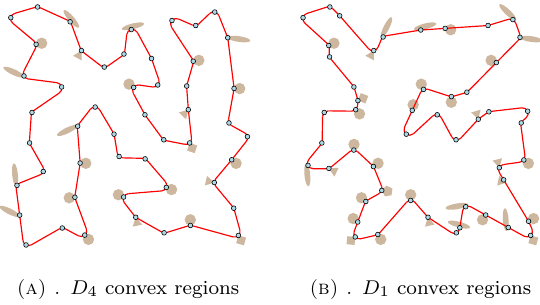
Figure 2. Examples of the randomly generated in- stances of the DTSPN.